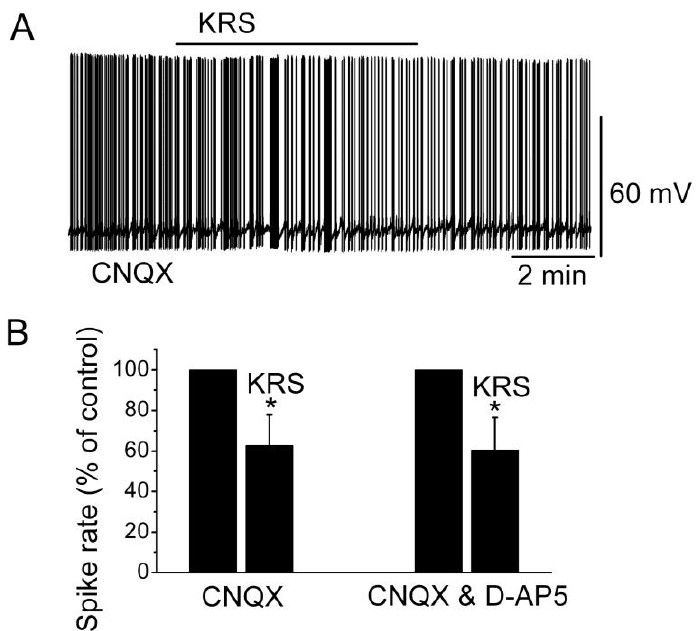
Figure 7. Neither AMPA/kainate nor NMDA receptor antagonists blocks the KRS-5Me-4- OCF 3 -induced inhibition of MCs. ( A ) KRS-5Me-4-OCF 3 -induced suppression of neuronal firing recorded in a representative mitral cell in the presence of CNQX (10 μM). ( B ) The normalized and averaged results showed the persistence of KRS-5Me-4-OCF 3 -induced inhibitory effects on spontaneous spiking of mitral cells in the presence of either CNQX or CNQX plus D-AP5 (50 μM) (* p < 0.05). From